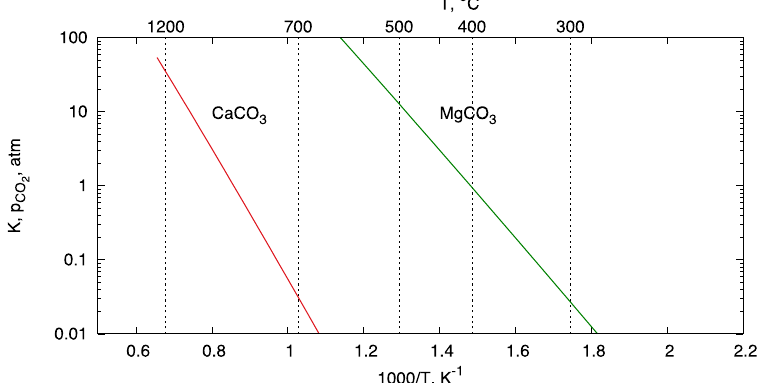
Figure 9. Thermodynamic equilibrium conditions for CaCO 3– CO 2 and MgCO 3– MgO systems.